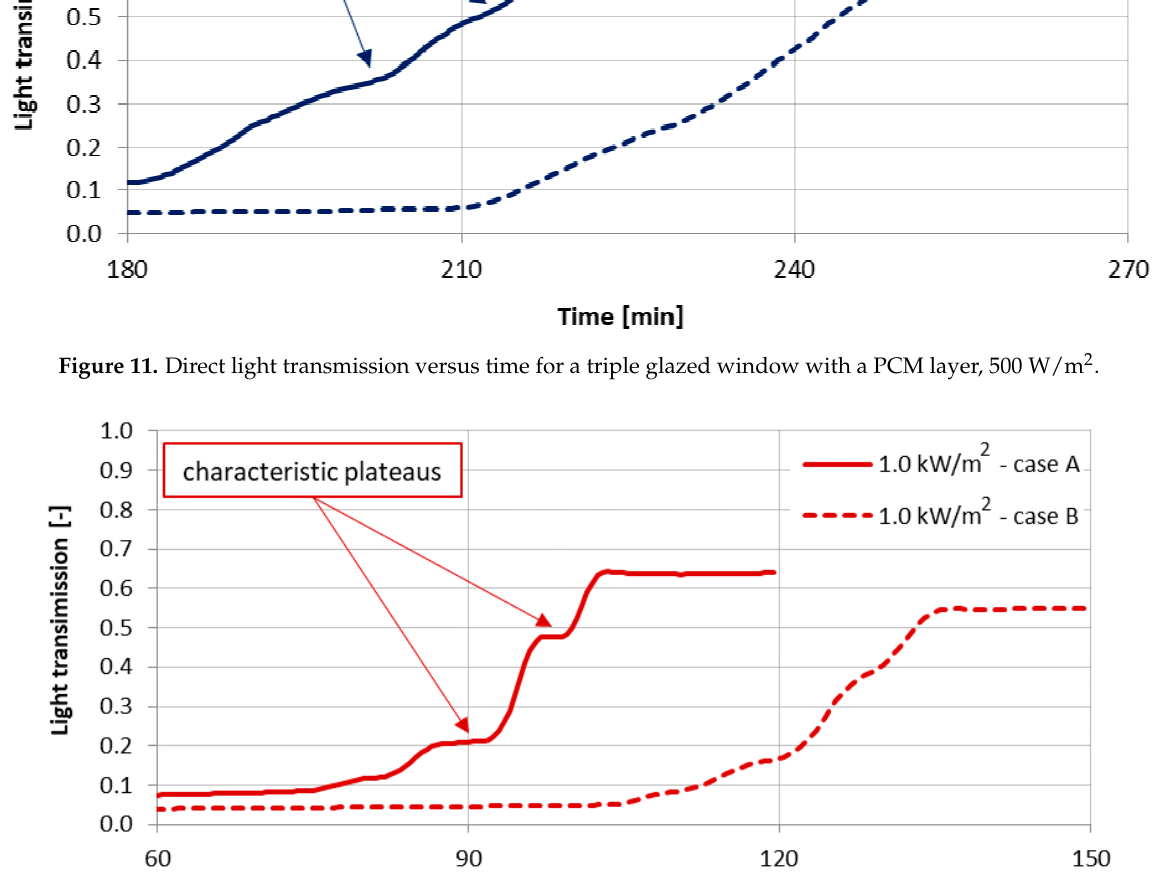
Figure 12. Direct light transmission versus time for a triple glazed window with a PCM layer. 1000 W/m 2 .